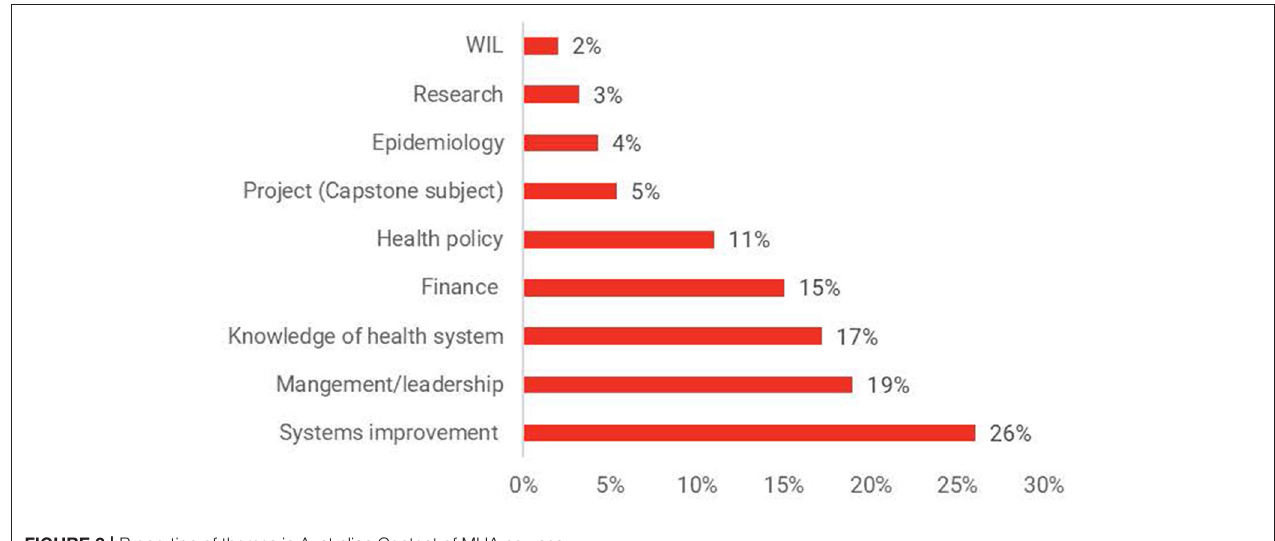
FIGURE 2 | Proportion of themes in Australian Content of MHA courses.